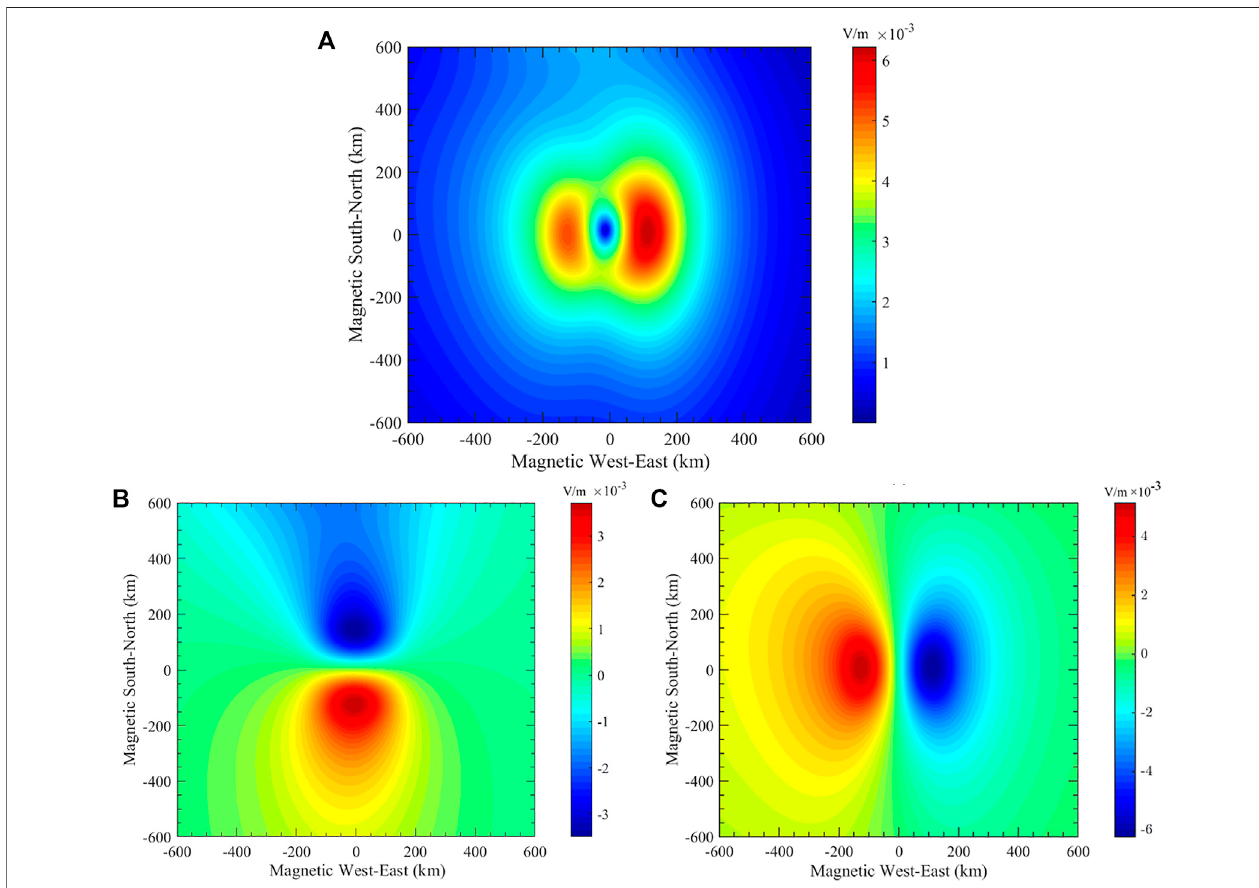
FIGURE 13 | Distribution of penetrating electric fi eld at the bottom of ionosphere (~90 km) by LAIC simulation. (A) Total horizontal electric fi eld. (B) Horizontal electric fi eldinthesouth – northdirection. (C) Horizontalelectric fi eldinthewest – eastdirection.Ineachpanel, X and Y coordinateaxesrepresentmagneticwest – eastand south – north direction, respectively.